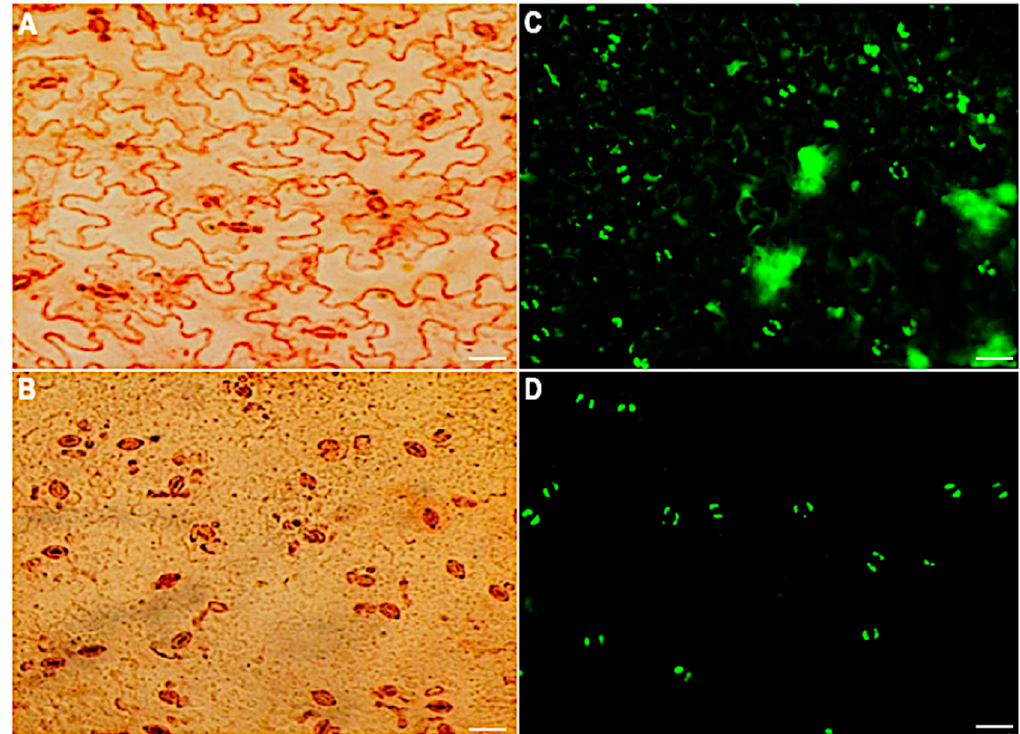
Figure 1. Stomatal guard cell purity and viability before and after the removal of mesophyll and epidermal cells. Neutral red viability staining of epidermal peels: ( A ) before digestion and ( B ) after digestion. FDA viability staining of the peels: ( C ) before digestion and ( D ) 60 min after digestion. Scale bar: 30 µm.